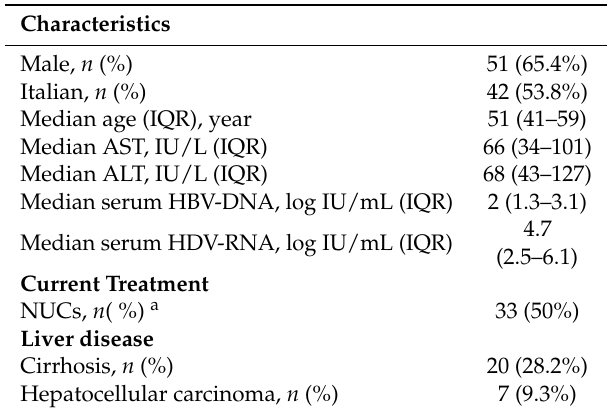
Table 1. Characteristics of 78 patients with HBV + HDV